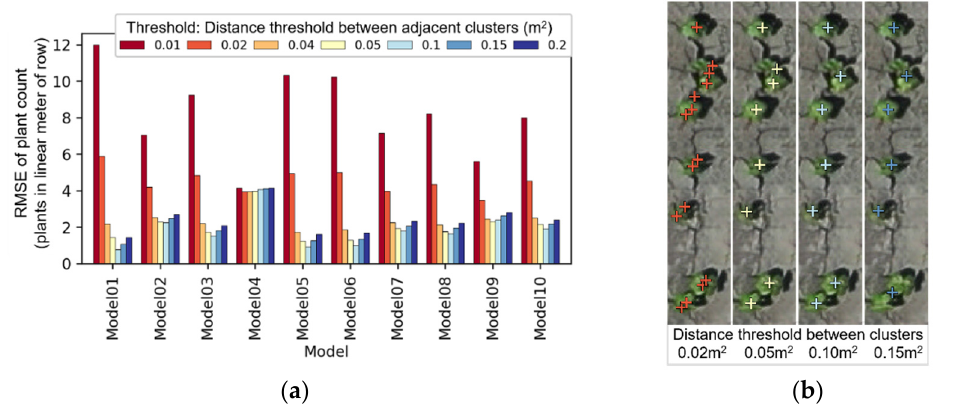
Figure 13. Relation of cluster distance threshold and average root mean square error (RMSE) of plant count ( a ); an example showing its effect on agglomerative clustering when Model 1 was used ( b ).